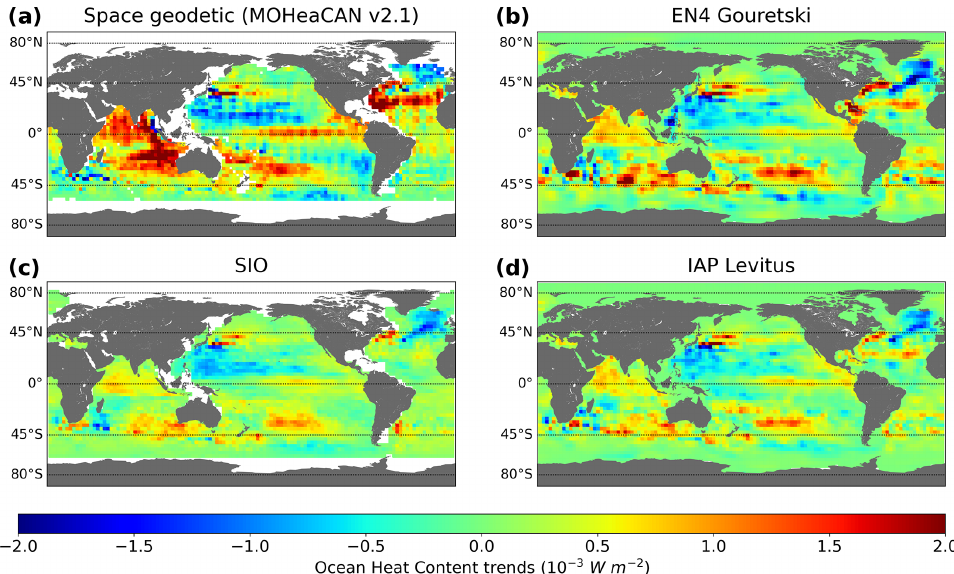
Figure 6. Maps of ocean heat content trends from the space geodetic approach for the period from January 2005 to December 2015 and at 3 ◦ × 3 ◦